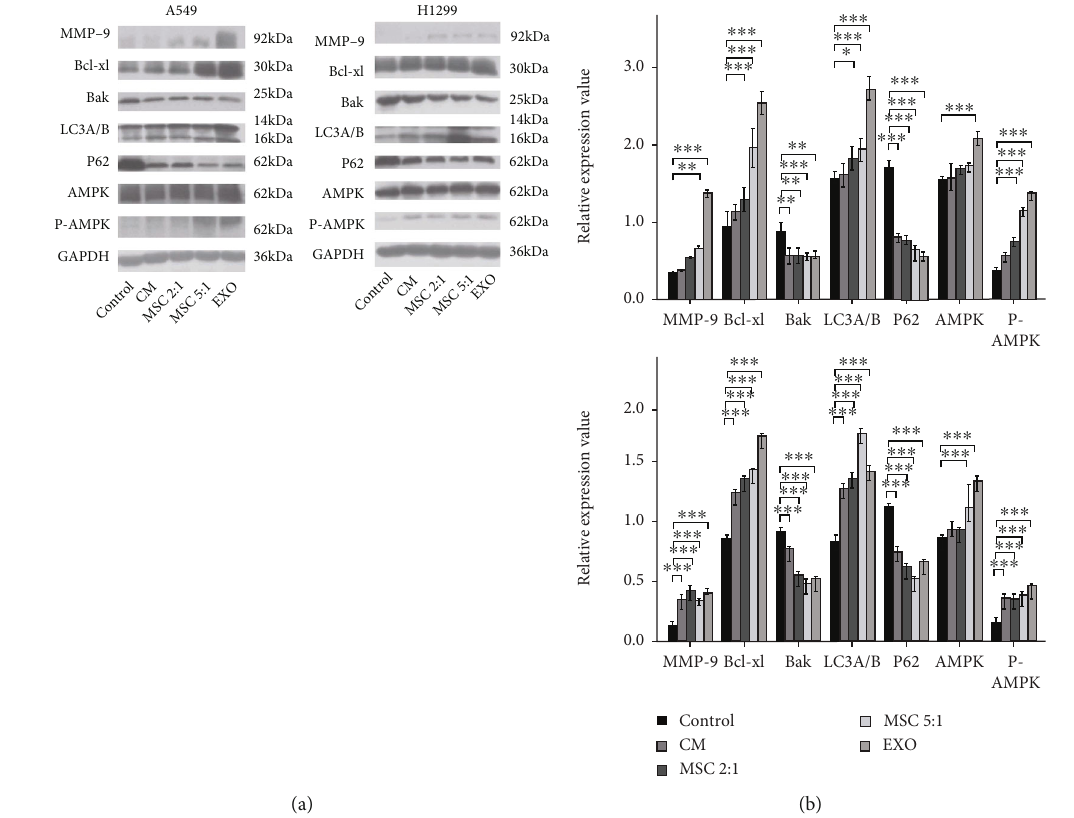
Figure 6: MSCs and MSC-exosomes activated AMPK signaling pathway in the polyploid A549 and H1299 cells. (a, b) Protein levels of MMP-9, Bcl-xl, Bak, LC3A/B, P62, AMPK, and phospho-AMPK (Thr172) in the polyploid A549 and H1299 cells following coculture with MSC-CM, MSCs, and MSC-exosomes were determined by Western blot